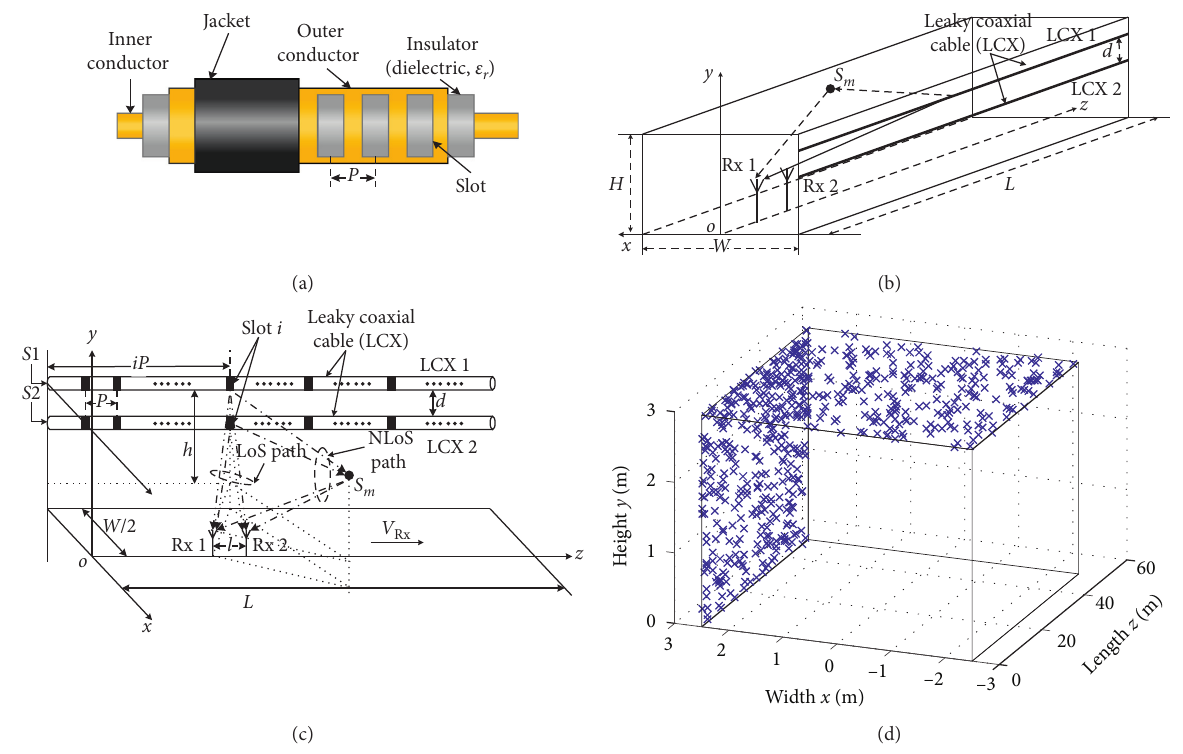
Figure 1: (a) Leaky coaxial cable (LCX) structure; (b) propagation scenario of MIMO using two LCXs in the tunnel; (c) nonstationary 3D LCX-MIMO channel model in the tunnel: single-bounce non-line-of-sight (NLoS) path ( − ∙∙ − ), line-of-sight (LoS) path ( − ∙ − ); (d) randomly distributed scatters ( × ) on the wall and roof of a tunnel with length L � 50m, width W � 5m, and height H �